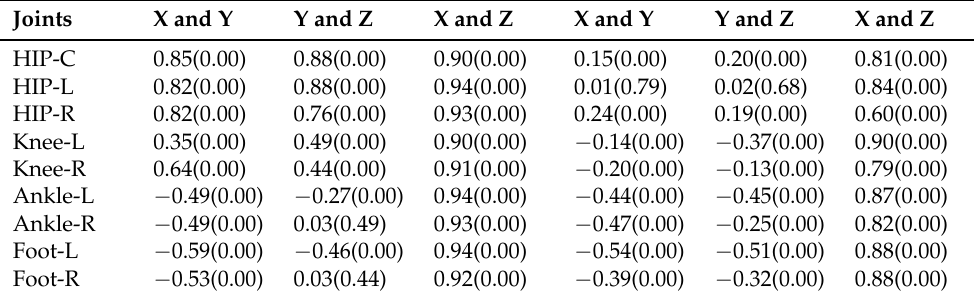
Table 2. Pearson correlations between several joints and directions in a three-dimensional coordinate system (X, Y, and